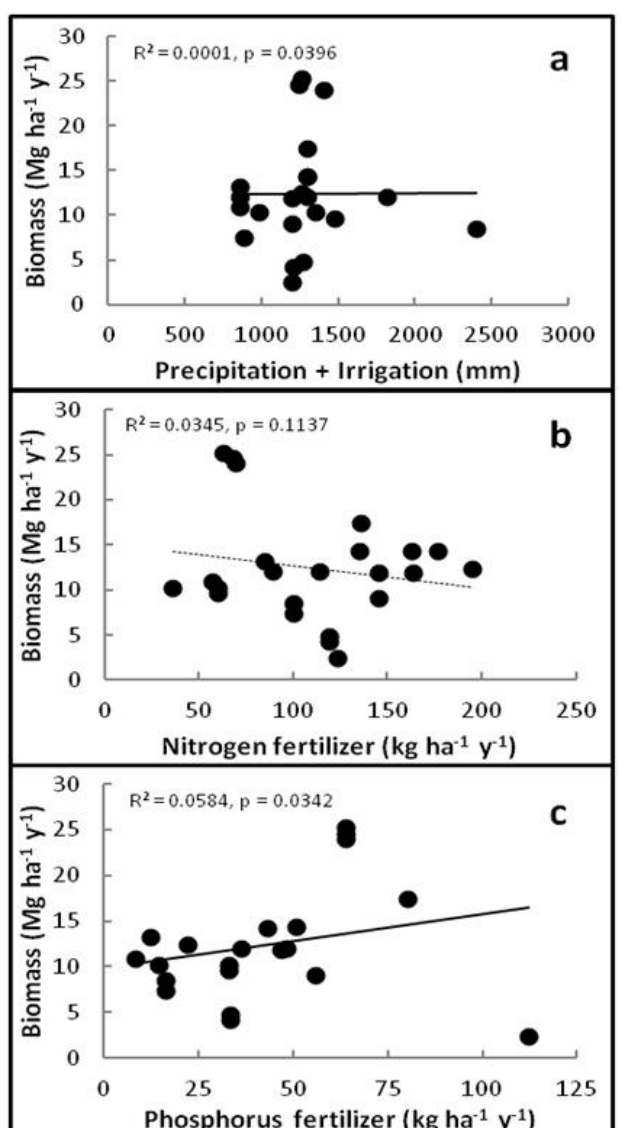
Figure 2. Annual growth response of loblolly pine plantation to water inputs ( a ) nitrogen fertilizer; ( b ) and phosphorus fertilizer; ( c ) p -values describe main effects